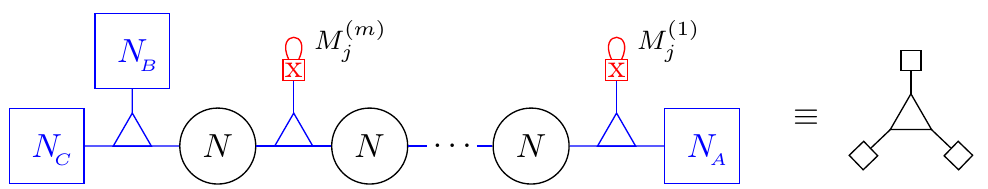
Figure 1. A UV generalized quiver description for the T ( m )